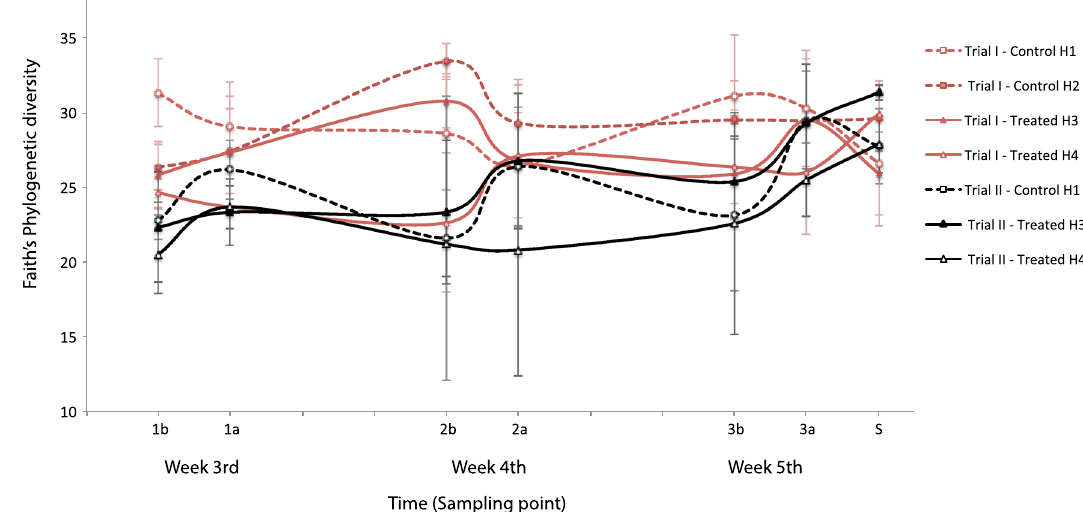
Figure 2. Alpha diversity using Faith phylogenetic diversity metric of samples throughout the experiment per farmhouse and trial. Red lines indicate Trial 1, black lines indicate Trial 2. Dotted lines represent control farmhouses and solid lines are for SalmoFree treated farmhouses. The x-axis indicates the time points for samples taken before (b) and after (a) the delivery of the treatments with their corresponding week of the cycle. The results at slaughterhouse are indicated as (S). Positions on the x-axis are proportional to the time intervals between sampling. Error bars represent the standard deviation of the mean of five cecum samples. This figure was made using Excel for Mac v.16.5 (https:// www. micro soft. com/ en- ww/ micro soft- 365/ mac/ micro soft- 365- for-